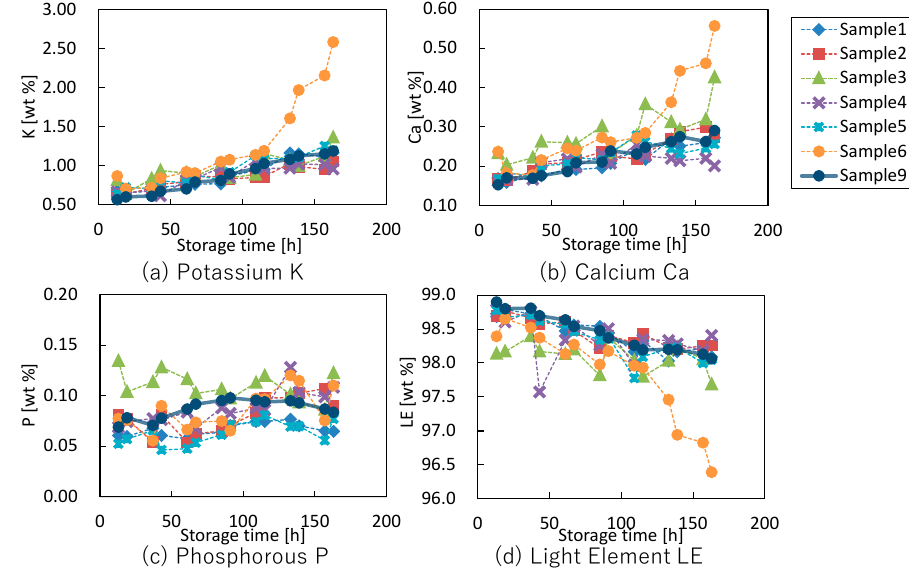
Fig. 14: Macronutrients (K, Ca, P) and light element (LE) change during FFiigg.. 1144 MMaaccrroonnuuttrriieennttss ((KK,, CCaa,, PP)) aanndd lliigghhtt eelleemmeenntt ((LLEE)) cchhaannggee dduurriinngg 713